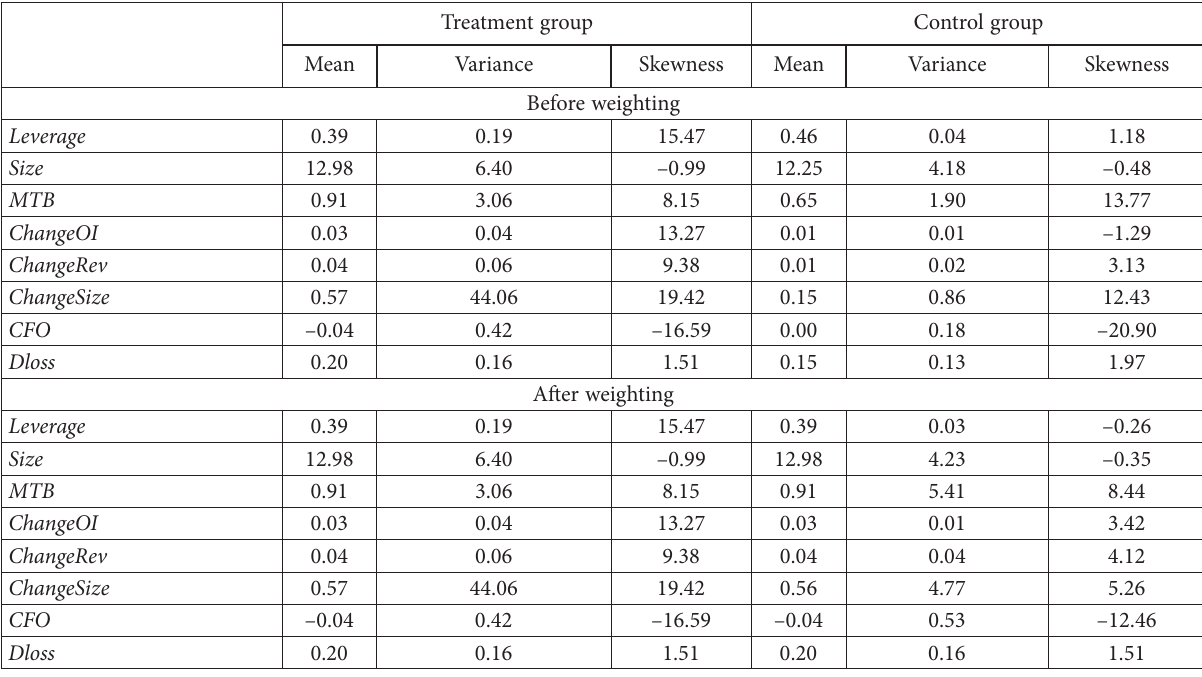
Table 9. Panel A statistical description of entropy-balanced samples